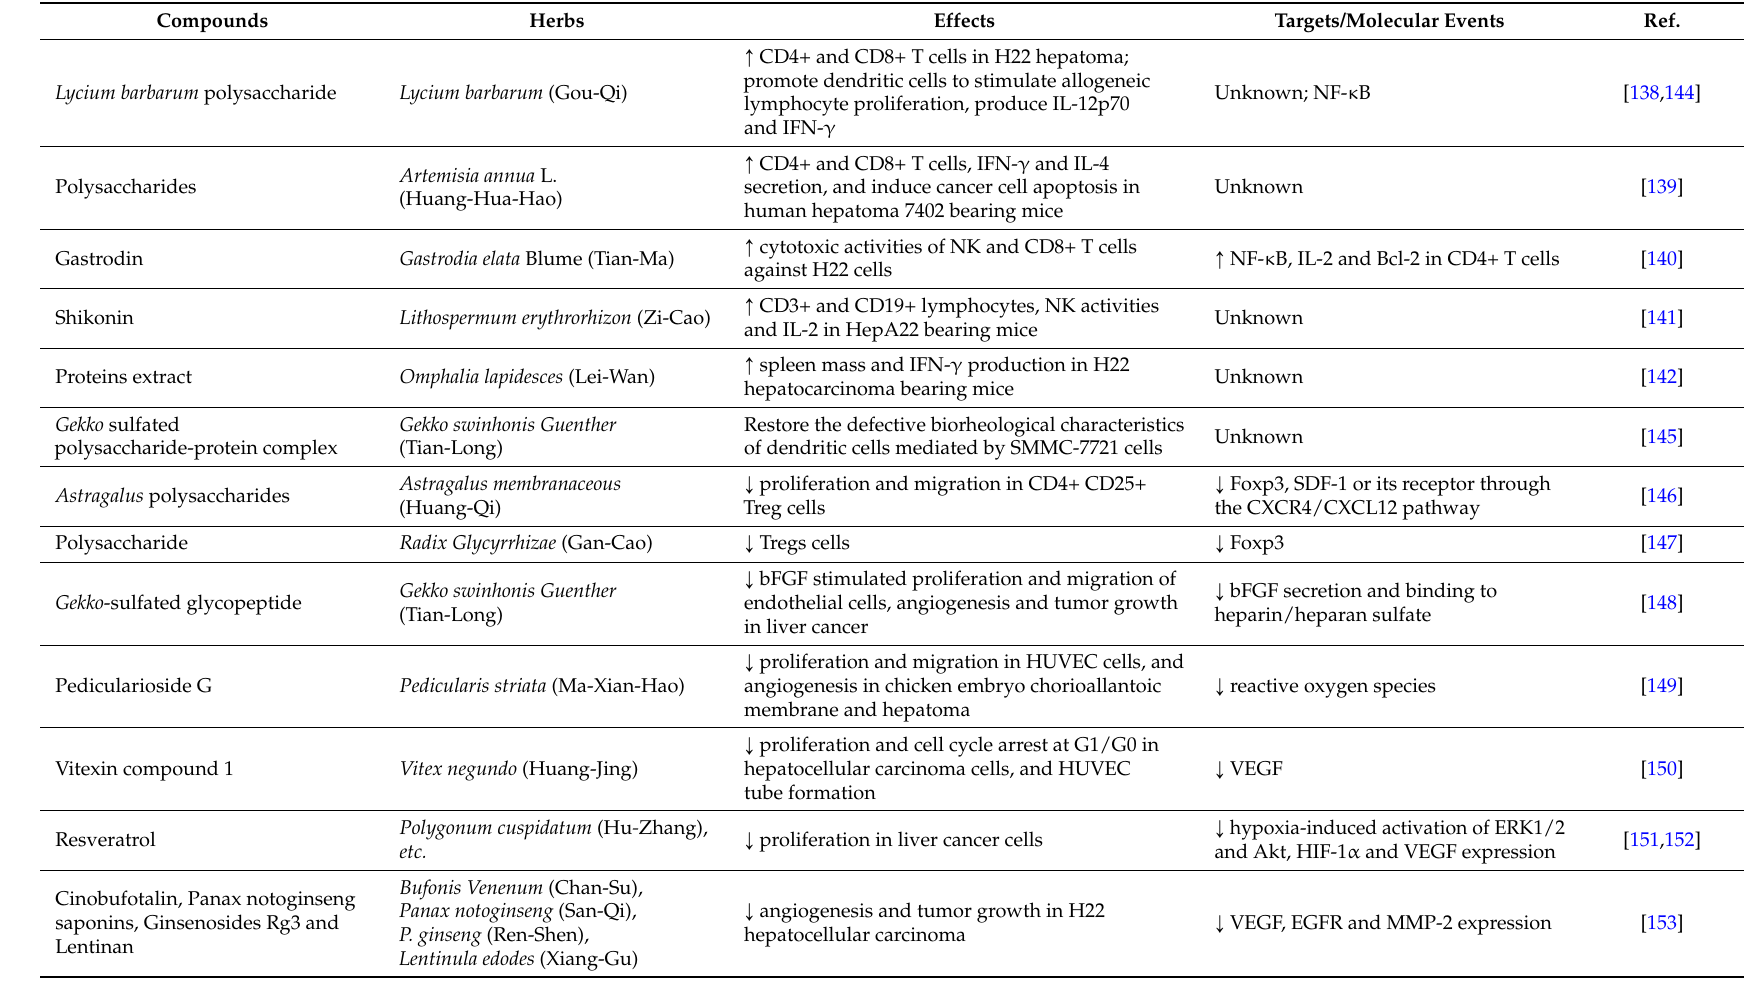
Table 3. Effects of herbal compounds on immune function and angiogenesis in